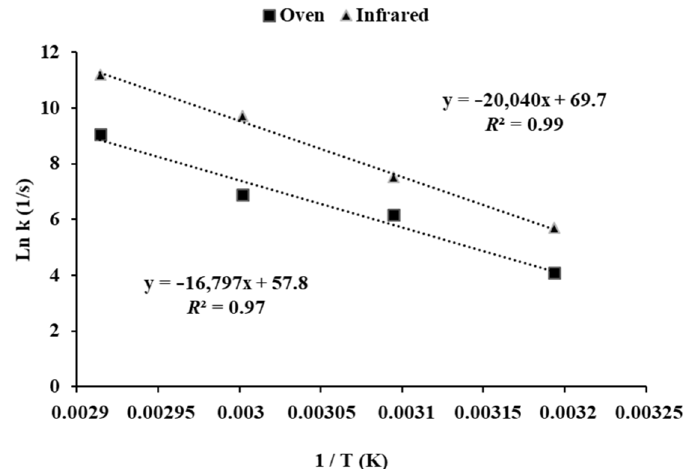
Figure 2. Arrhenius-type relationships between the drying constant rate and temperature obtained during the dehydration of olive leaves using the oven or infrared heating.